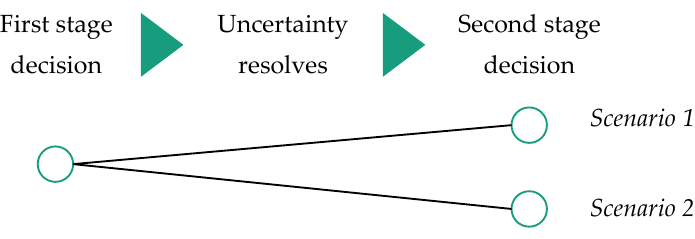
Figure 1. Decision tree for a two-stage SP model, based on [50].